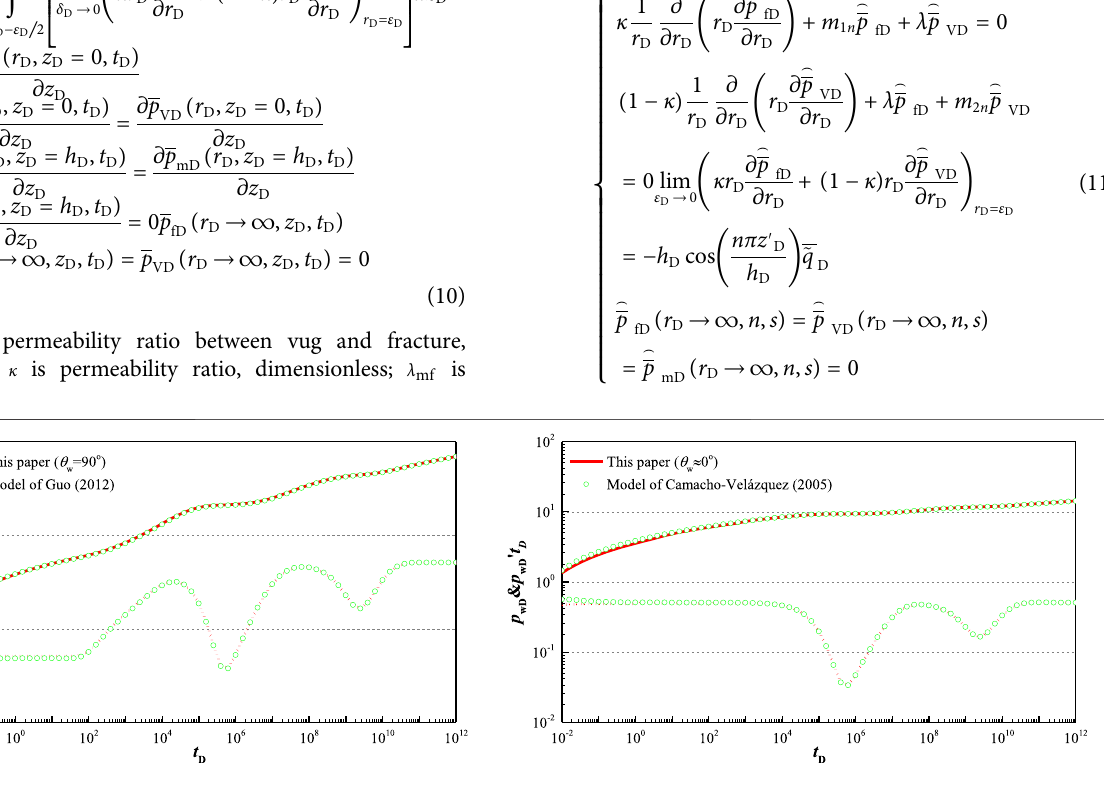
FIGURE 5 | Comparison with Guo et al. (2012) and Camacho-Velázquez et al. (2005) models ( h (cid:2) 100 , h w (cid:2) 100 . 4 , r w (cid:2) 0 . 1 , k hv (cid:2) 1 , k D (cid:2) 1 , κ (cid:2) 0 . 7 , ω f (cid:2) 0 . 001 , ω (cid:2) 0 . 1 , λ (cid:2) 10 − 12 , λ (cid:2) 10 − 10 , λ (cid:2) 10 − 8 V mf mV Vf